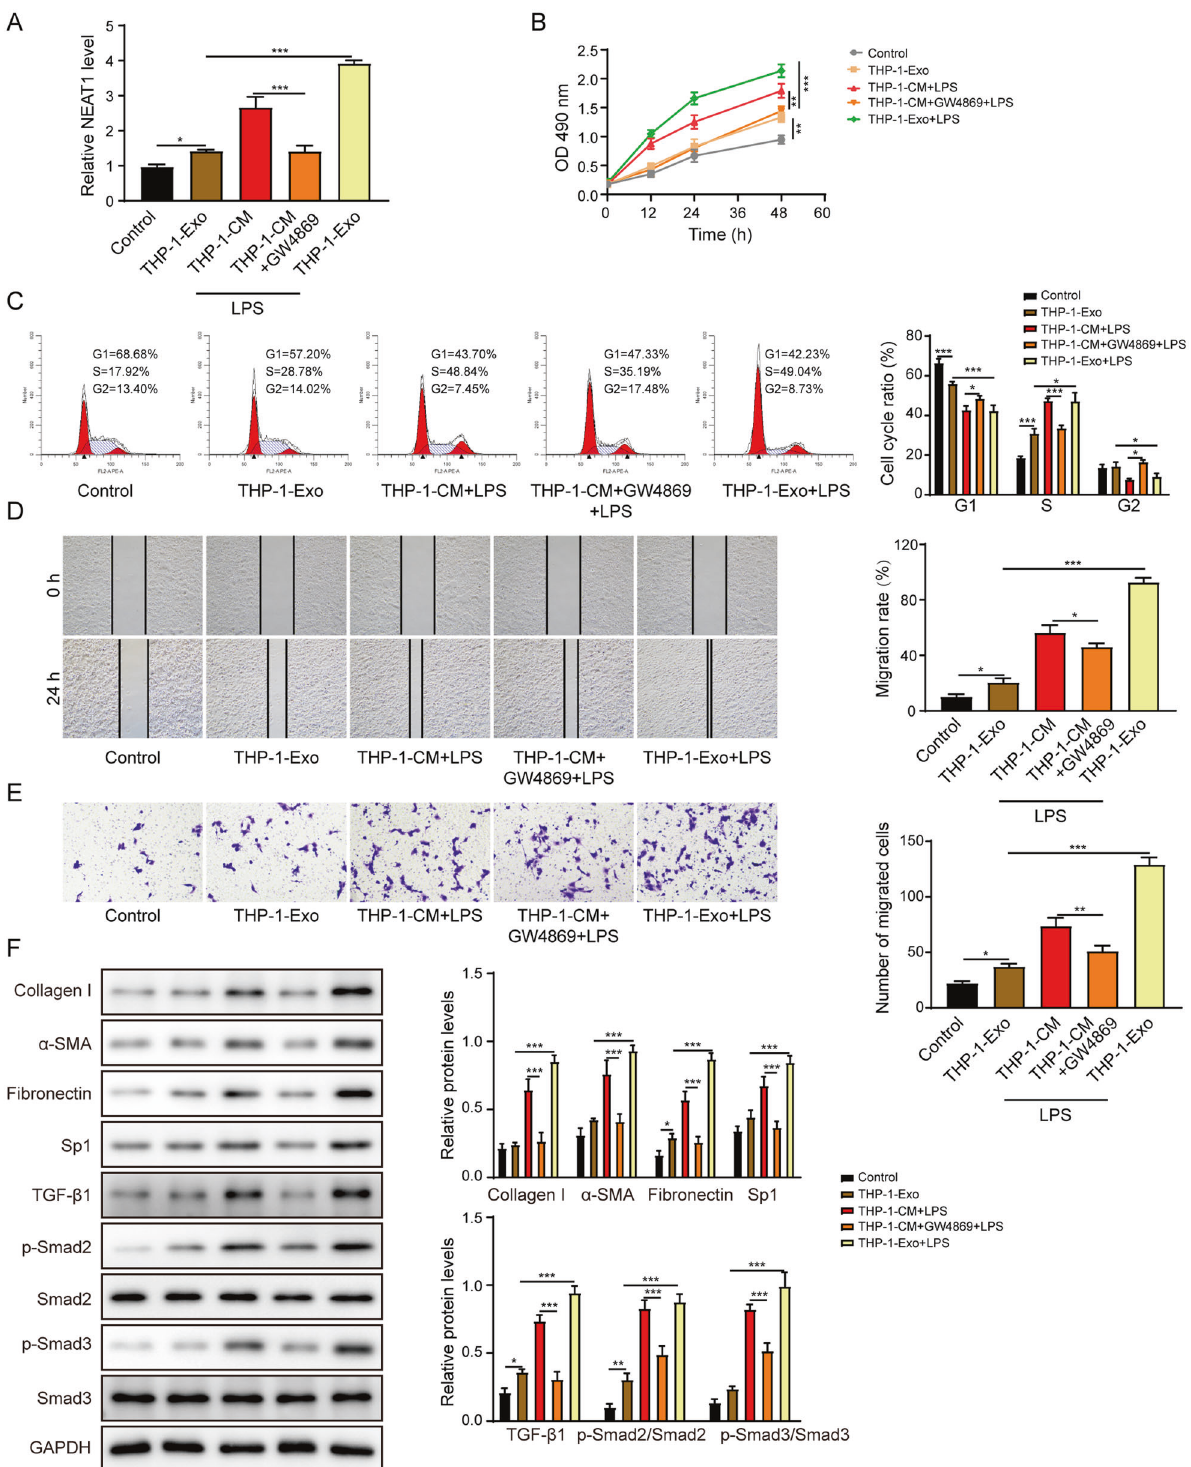
Fig. 2 Exosomes extracted from LPS-treated THP-1 macrophages enhance the activation of HSCs. A The NEAT1 expression level was determined by qRT-PCR. B The proliferation of the LX-2 cells was examined by the CCK-8 assay. C The cell cycle of the LX-2 was examined by the fl ow cytometry. D , E The migration of LX-2 was determined by the scratch assay ( D ) and the transwell assay ( E ). F Western blot analysis of the protein levels of collagen I, α -SMA, fi bronectin, Sp1, TGF- β 1, p-Smad2, Smad2, p-Smad3, and Smad3. * p < 0.05; ** p < 0.01; *** p < 0.001.